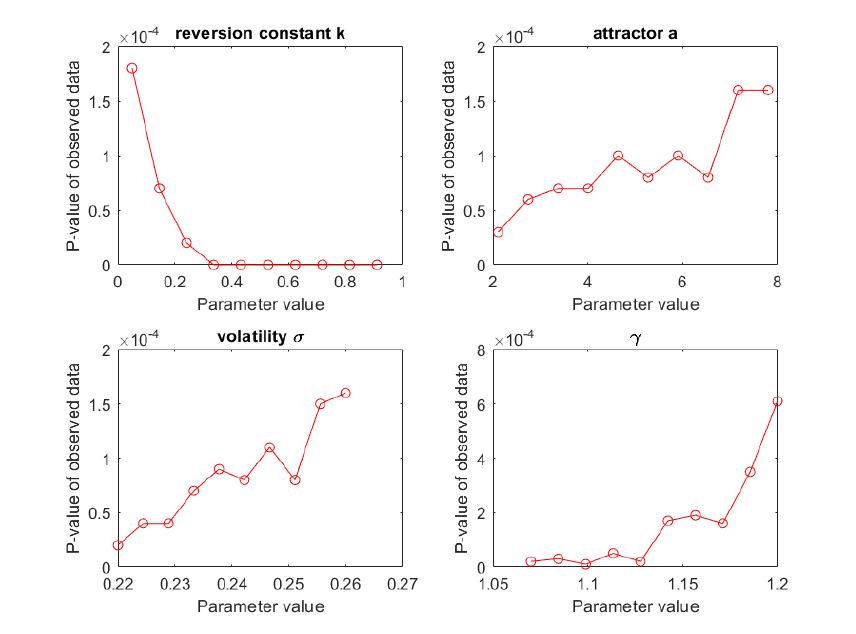
Figure 6. Marginal sensitivity of the p -value of the response test statistic ( T obs ) for r = 50 to changes in the four parameter values. The parameters varied between their respective 5% and 95% percentiles. It turns out that the p -value remained highly significant over these